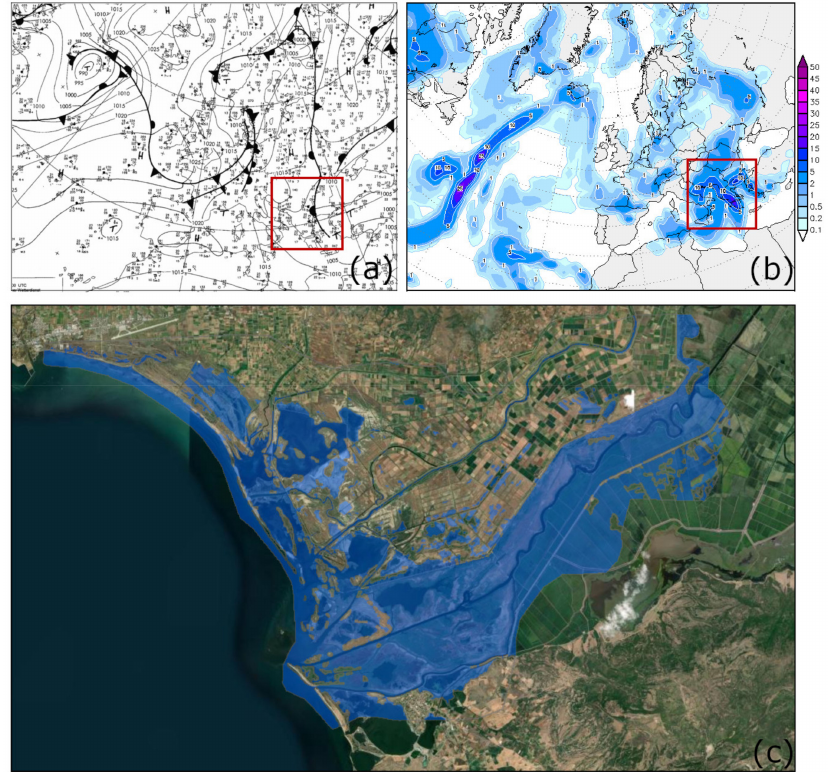
Figure A1. ( a ) Surface weather chart and ( b ) the respective precipitation map at a time close to the reported onset of the 2005 flood event; the red squares indicate the broader study area. ( c ) The flooded area of the Evros river deltaic plain at a time associated with the flood event. The dates corresponding to each map are given in Table